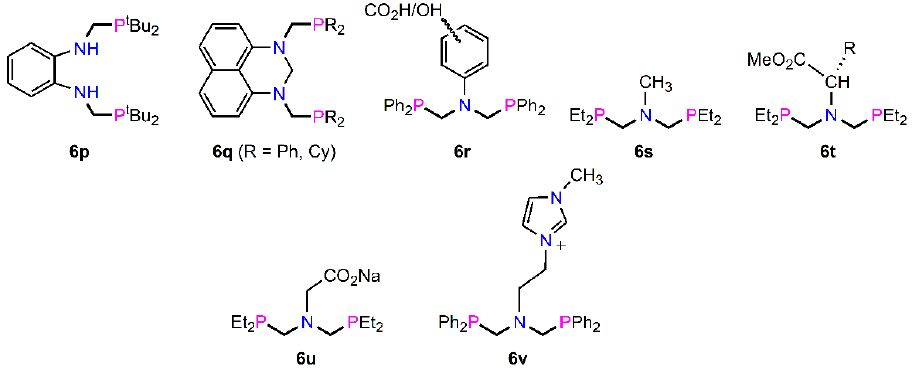
Figure 9. Selected examples of P–C–N–C–P ligands.